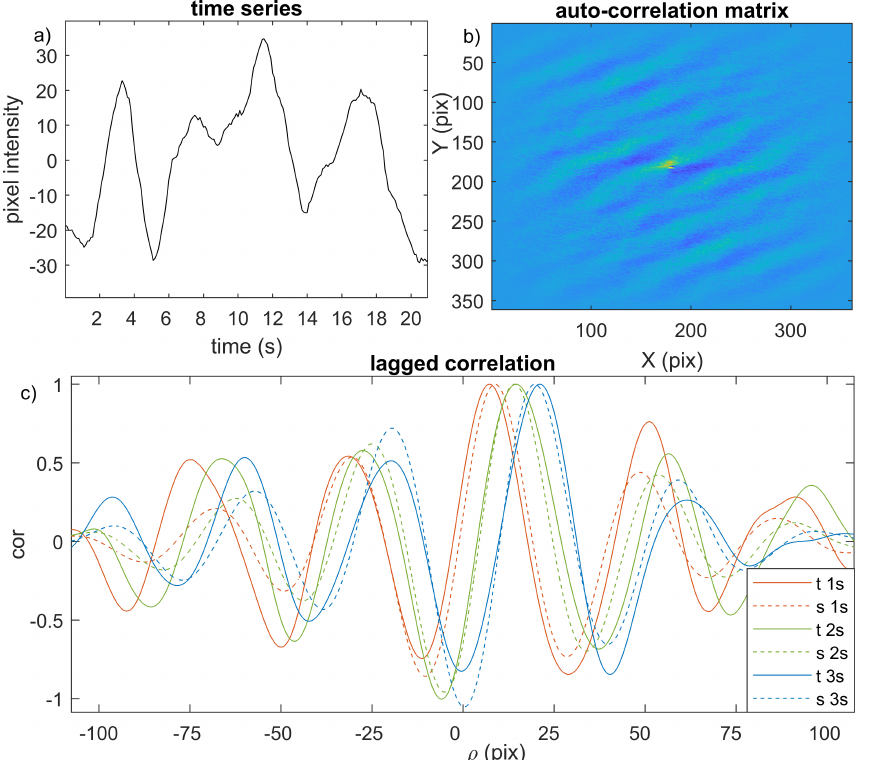
Figure 2. Principle of the method employed. ( a ) Pixel intensity anomaly timeseries, ( b ) matrix of lagged correlation (at dpha = 3 s), and ( c ) lagged correlation along the peak direction (in the Radon sinogram in polar space), with ρ the radius from the center of the computation window and different dpha from 1 s to 3 s for the temporal and spatial